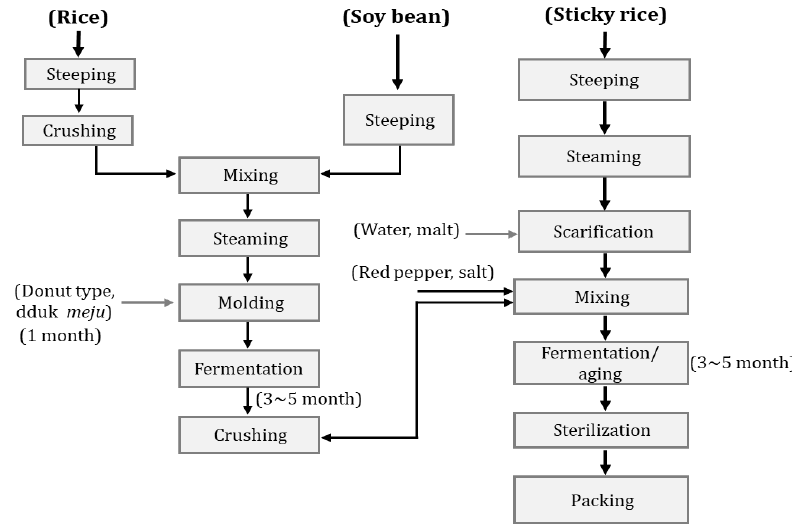
Figure 8. General manufacturing process of traditional gochujang.